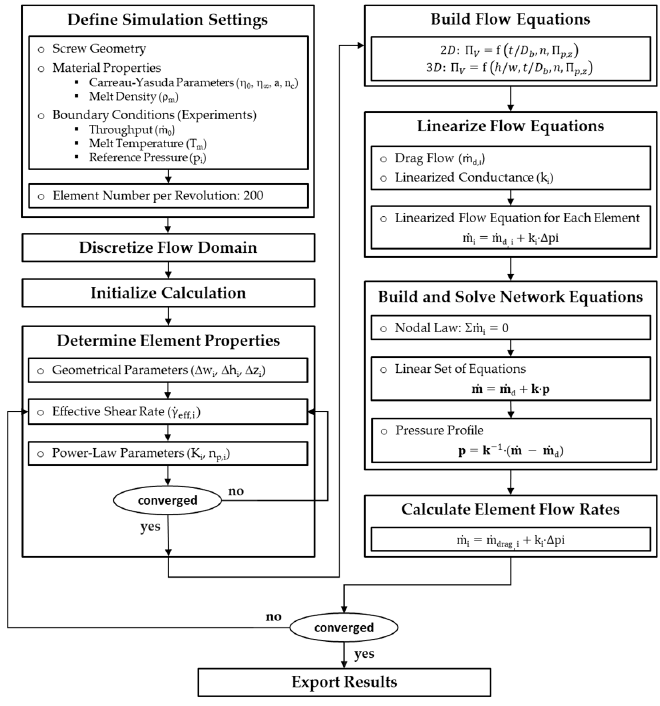
Figure 11. Flow chart of our semi-numerical modeling approach based on network theory.